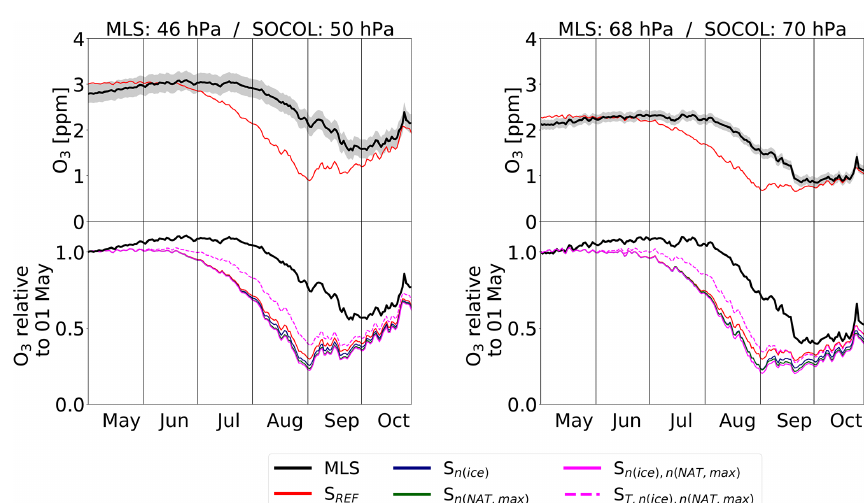
Figure A14. As Fig. 9, but for the year 2010.